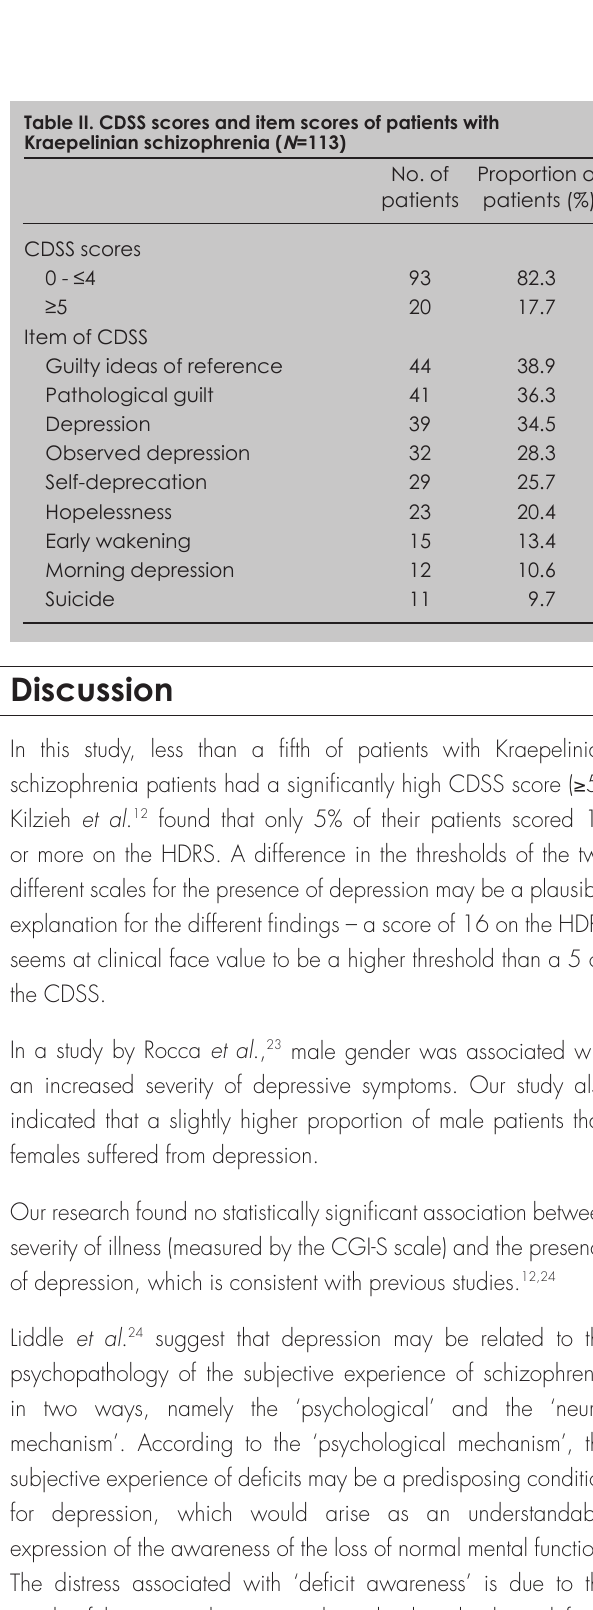
Table II. CDSS scores and item scores of patients with Kraepelinian schizophrenia (N=113)